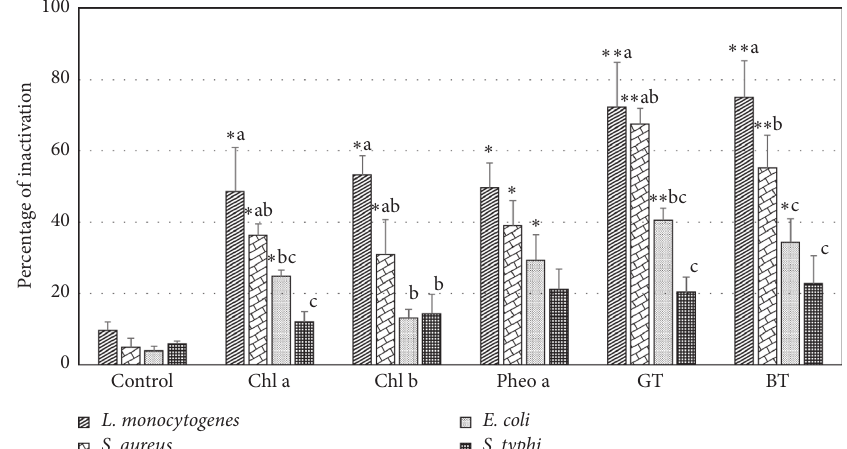
Figure 5: Percentage of bacterial inactivation after incubation of single broth cultures with various sensitizers under illumination of red LED for 30min. The types of applied sensitizers were as follows: sterile 1% Tween 80 as the medium for pigments dispersion (control), chlorophyll a (Chl a), chlorophyll b (Chl b), pheophytin a (Pheo a), and pigments extracted from the dregs of green tea (GT) and black tea (BT). The error bars represent standard error of the mean for three repetitions in each treatment. The upper symbols denote statistical significance based on treatment to control comparison using Dunnett’s test at confidence level of 0.95 ( ∗ ) and 0.99 ( ∗∗ ), whereas the different letters indicate significant differences ( p < 0.05) among bacterial species in the same group of